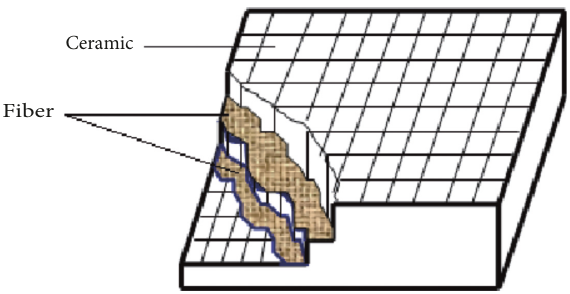
Figure 4: The composition of the FC Table 1: Configurations of the FC targets.